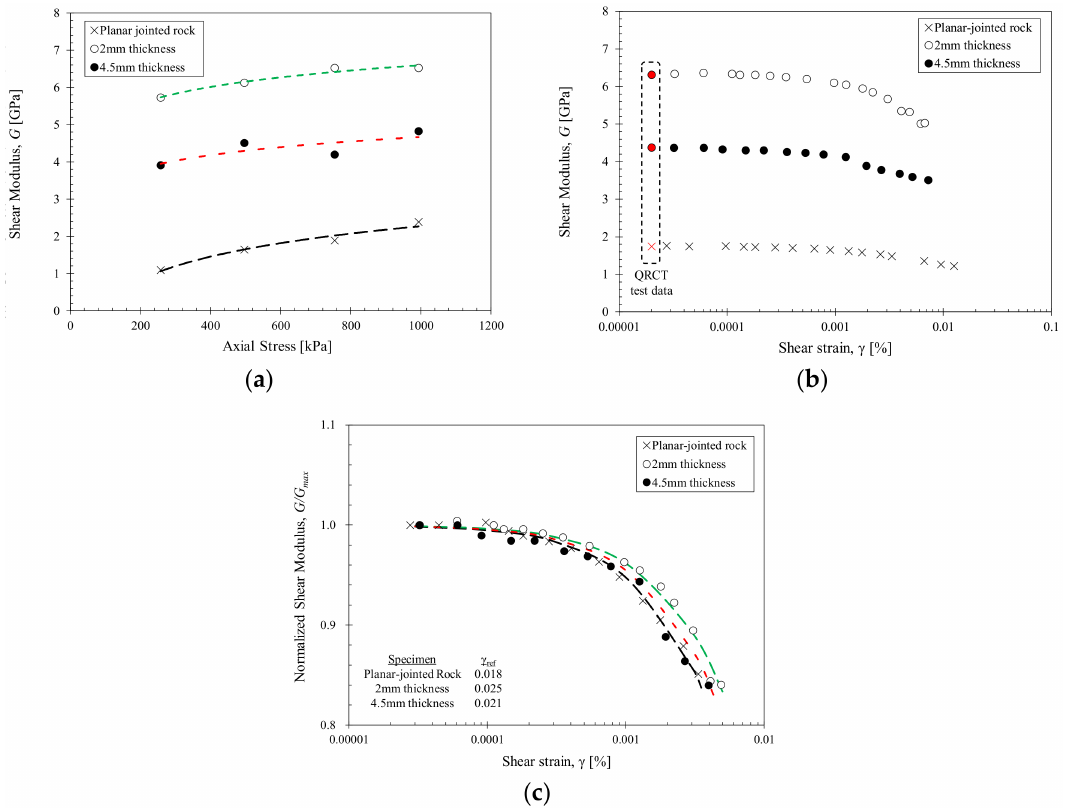
Figure 5. Stress- and strain-dependent properties of the planar-jointed rock with a grouted joint thickness of 2 mm and 4.5 mm after 7 days of curing. The properties of the planar-jointed rock are shown as a reference. ( a ) Stress-dependent small-strain shear modulus for 250, 500, 750 and 1000 kPa axial stress; ( b ) Strain-dependent shear modulus at 500 kPa axial stress. The small-strain shear modulus shown in red is obtained from the small-strain shear wave velocity; ( c ) Normalized shear modulus degradation curve. The data is fitted using the hyperbolic